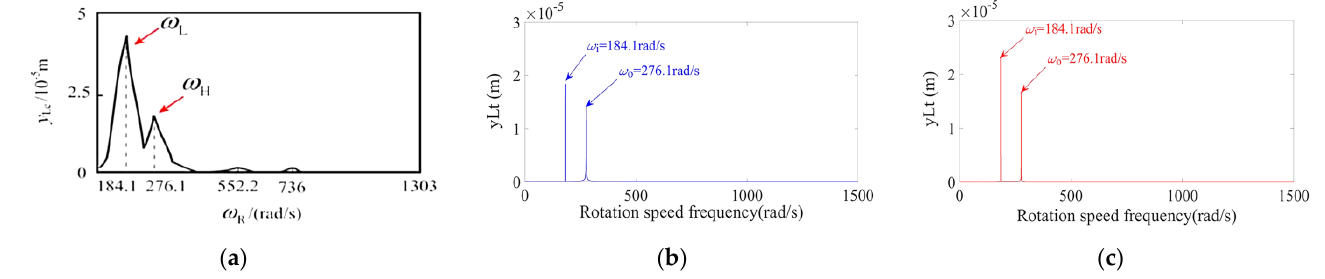
Figure 8. Displacement response of the dual-rotor system ( ω i = 184.1 rad/s; ω o = 276.1 rad/s). ( a ) Yang’s experimental result; ( b ) numerical result of the conventional MSDS; ( c ) numerical result of the nonlinear MSDS.